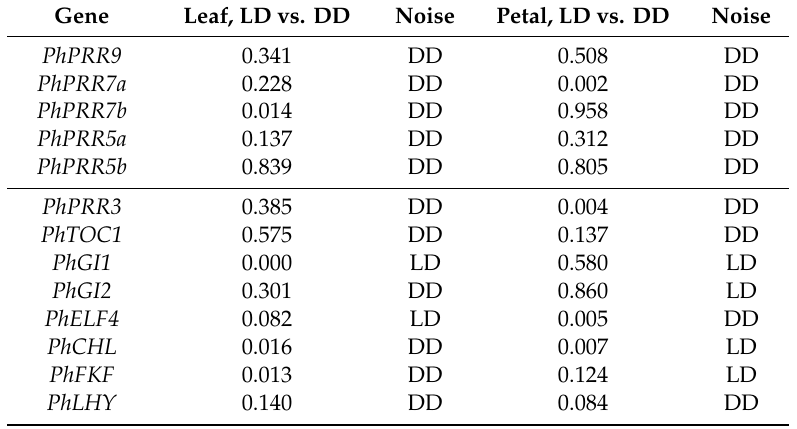
Table 3. Detection of changes in noise in petunia clock genes in two tissues, leaves and petals, comparing light:dark (LD) and constant darkness (DD) cycles. This analysis was performed by using the function HarmScaleTest provided by the R package DODR. A p value < 0.05 indicates significant changes between LD and DD, the phase with higher variability is specified in Noise columns. Gene Leaf, LD vs. DD Noise Petal, LD vs. DD Noise PhPRR9 0.341 DD 0.508 DD PhPRR7a 0.228 DD 0.002 DD PhPRR7b 0.014 DD 0.958 DD PhPRR5a 0.137 DD 0.312 DD PhPRR5b 0.839 DD 0.805 DD PhPRR3 0.385 DD 0.004 DD PhTOC1 0.575 DD 0.137 DD PhGI1 0.000 LD 0.580 LD PhGI2 0.301 DD 0.860 LD PhELF4 0.082 LD 0.005 DD PhCHL 0.016 DD 0.007 LD PhFKF 0.013 DD 0.124 LD PhLHY 0.140 DD 0.084